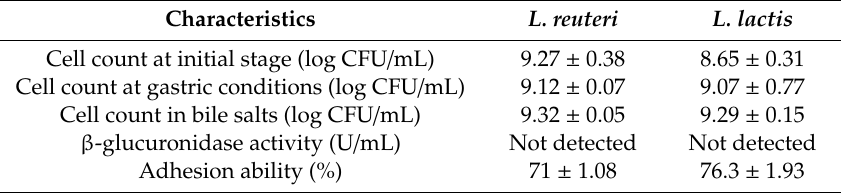
Table 1. Probiotic characteristics of Lactobacillus (LAB) isolated from pineapple